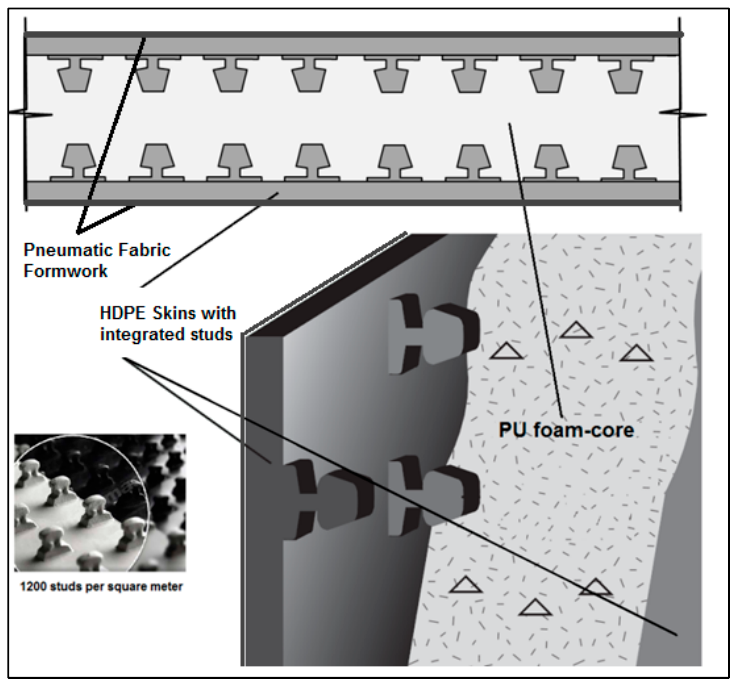
Figure 1. Sandwich with 3D high-density polyethylene (HDPE) skins, polyurethane (PU) foam-core, and pneumatic formwork.